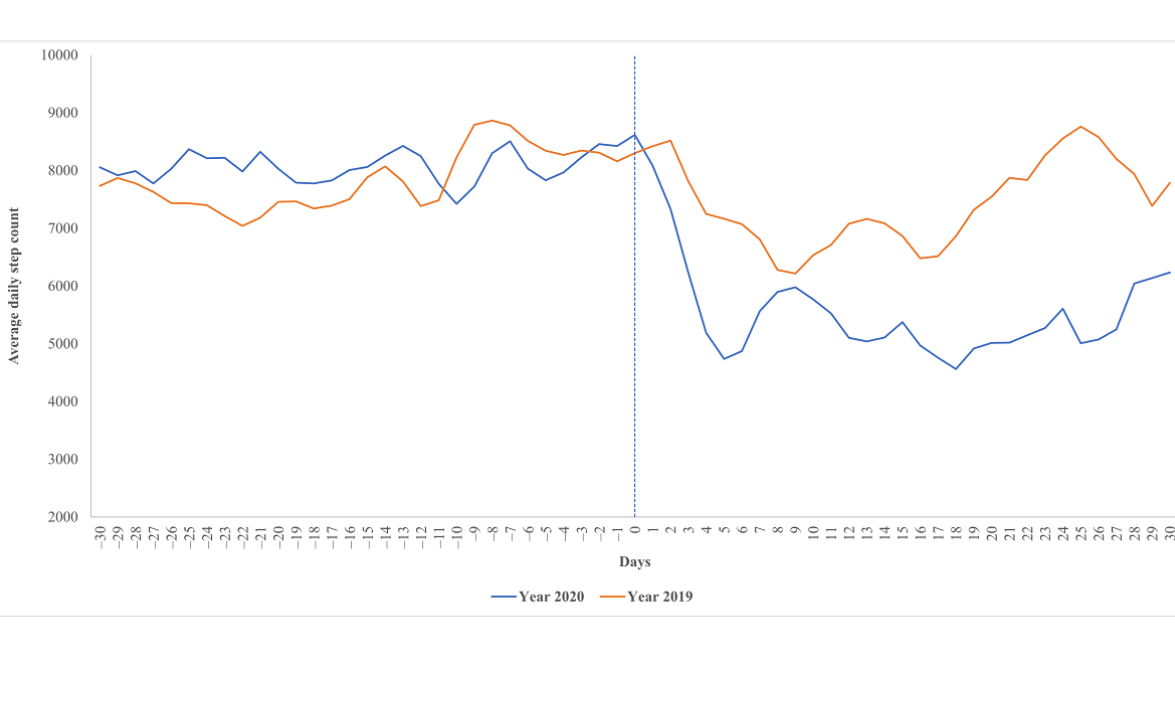
Figure 1. Average daily step count around the Chinese Lunar New Year period among participants in 2019 and 2020. Day 0 represents the index date; in 2020, this represents the date of the first COVID-19 case diagnosed in Changsha.